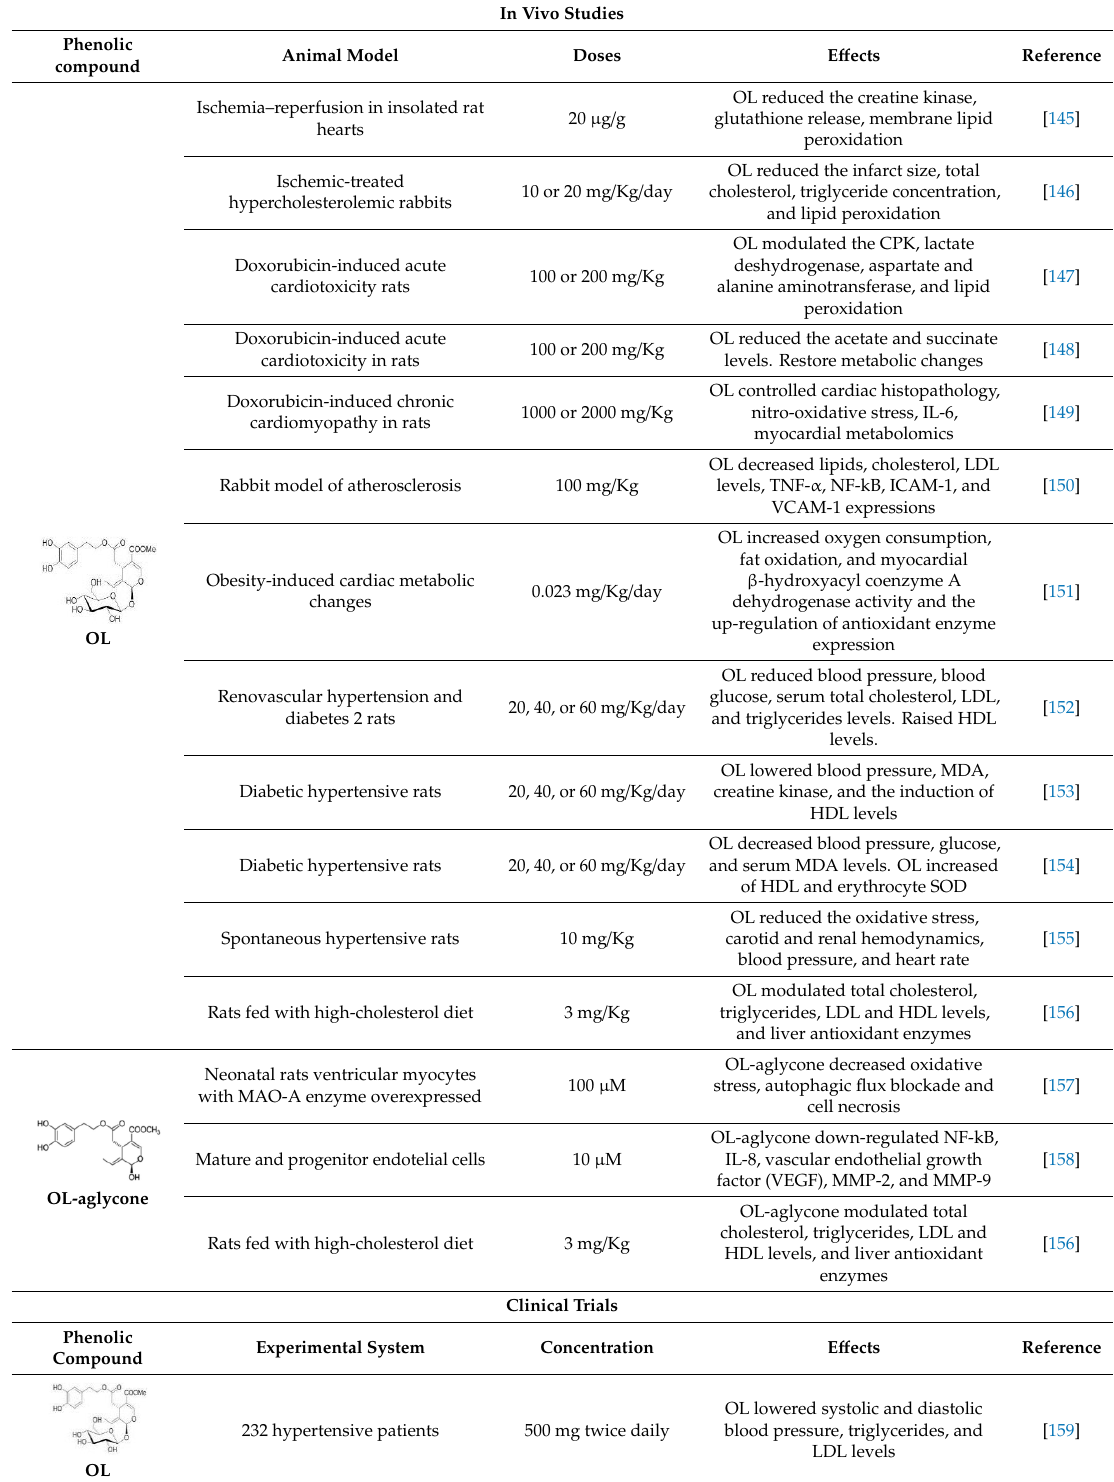
Table 4. Beneficial e ff ects of secoiridoids from the olive tree in the control and progression of di ff erent types of cardiovascular diseases: in vivo and clinical studies.